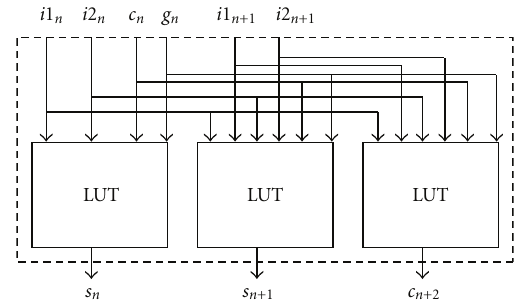
Figure 6: Optimized elementary cell for six-to-seven-input LUT.